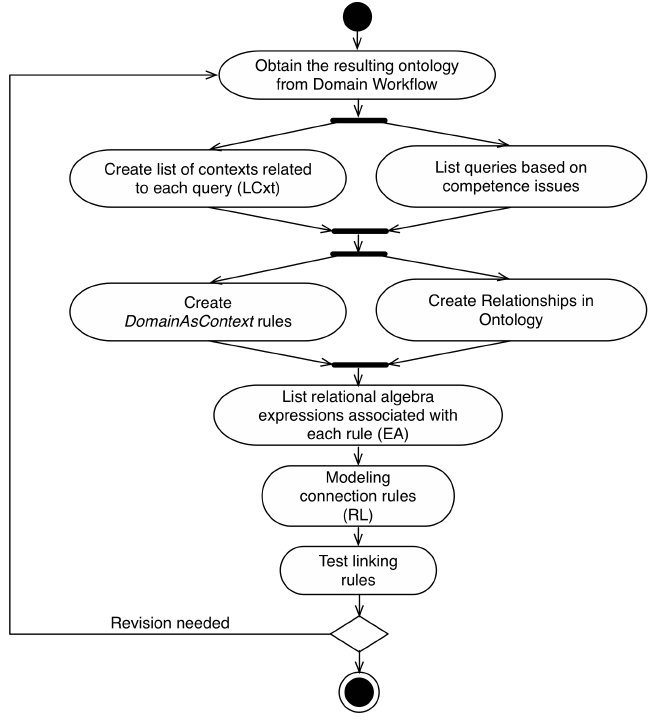
Figure 7. Overview of Alignment